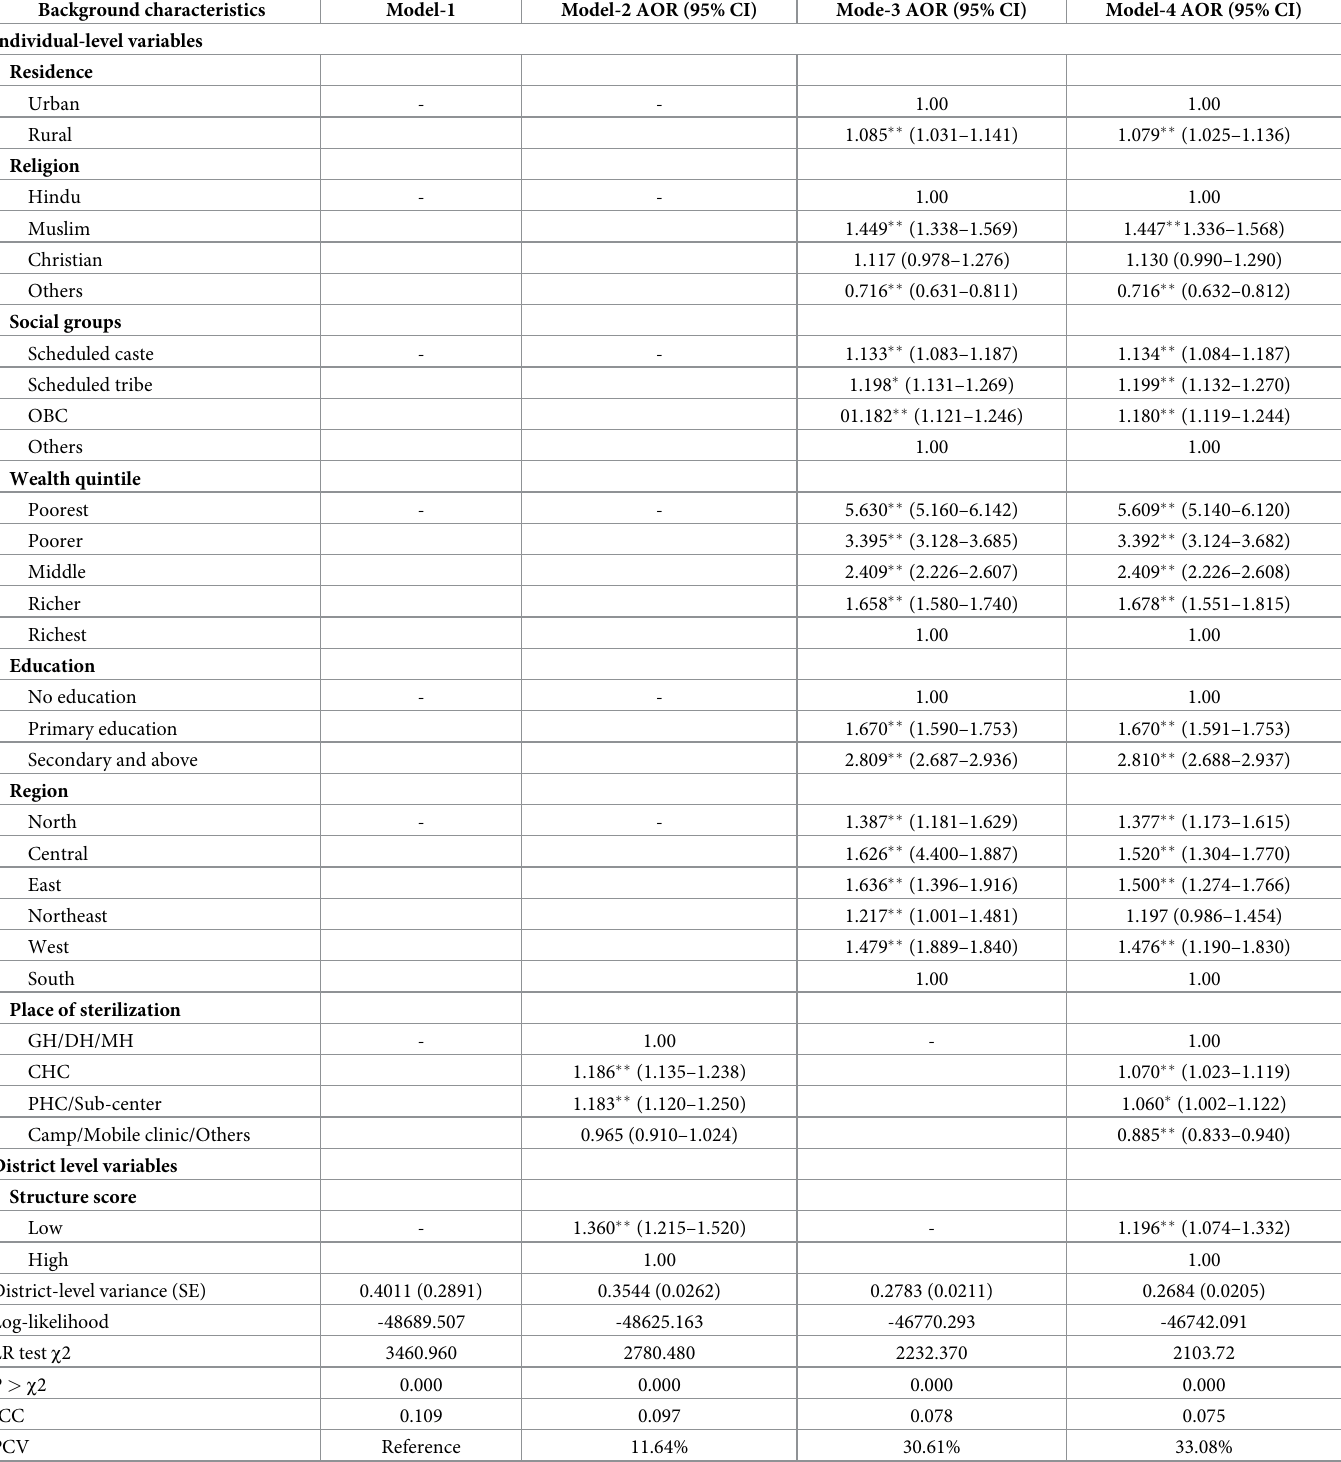
Table 2. Multilevel logistic regression analysis of factors associated with ‘low’ quality of care in sterilization services in